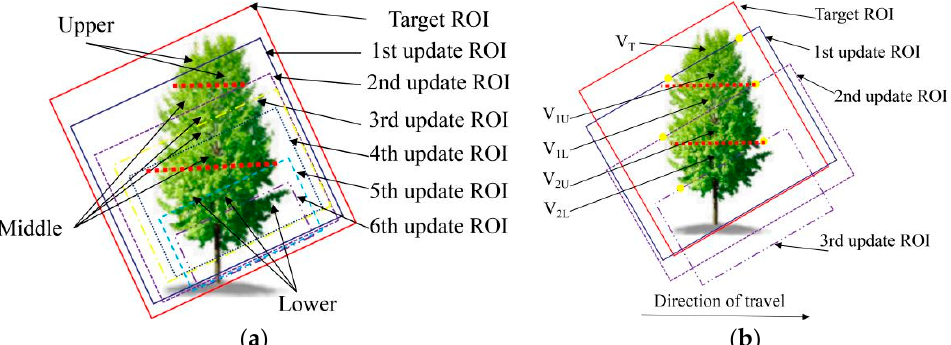
Figure 9. Canopy zoning and volume calculation. ( a ) Canopy volume acquisition schematic; ( b ) fruit tree stratification.